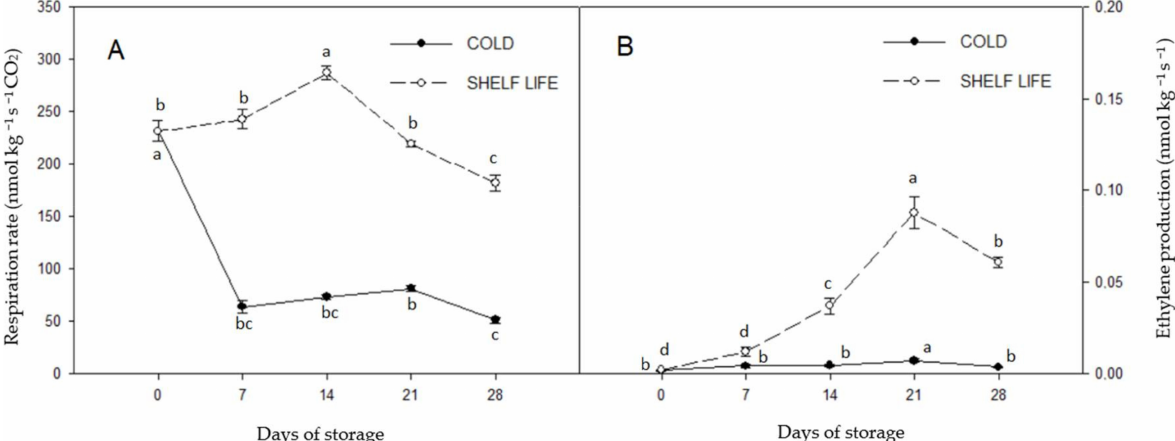
Figure 1. Changes in respiration rate ( CO 2 ) ( A ) and ethylene concentration ( B ) in cactus pear fruit during storage under cold and shelf life conditions. Data are the mean ± standard error (SE) ( n = 6). Tukey’s test result at a 95% confidence level is shown. Different letters indicate significant differences ( p < 0.05) during each storage